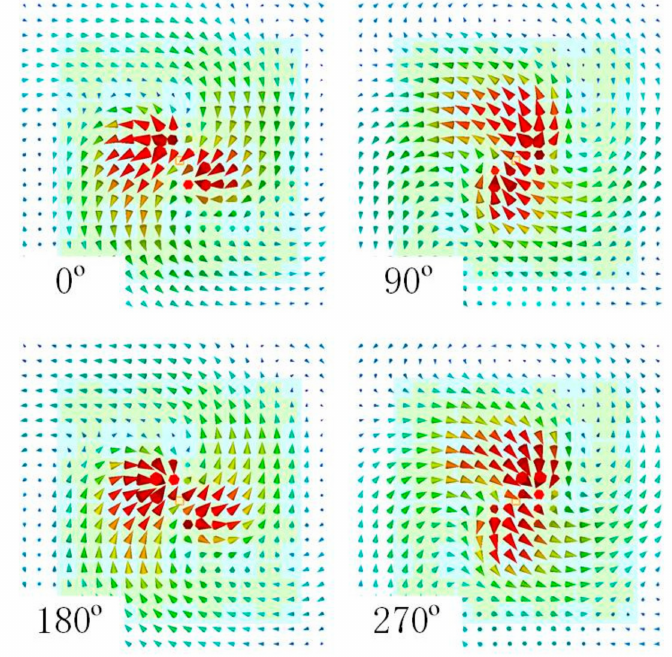
Figure 12. Simulated E-field 10 mm above the antenna